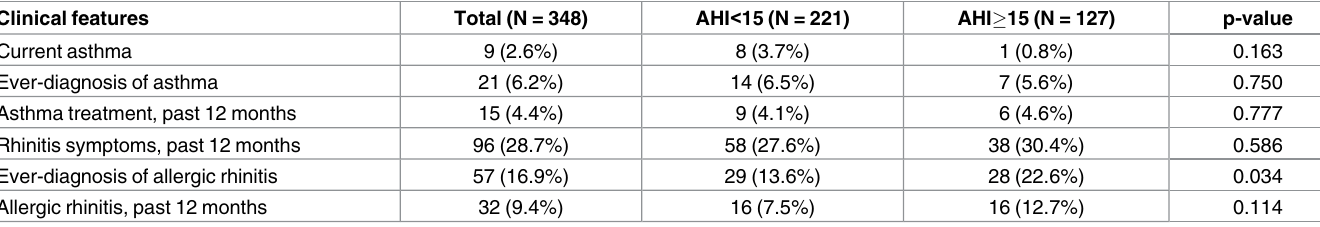
Table 2. Prevalence of asthma and rhinitis according to sleep disordered